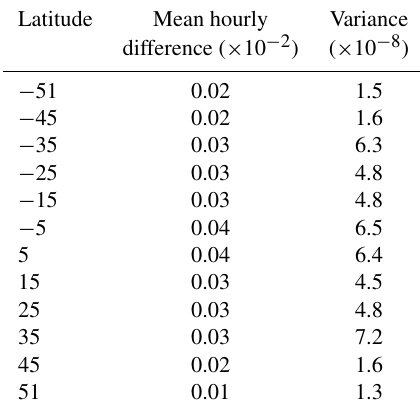
12.95 ◦ E based on three oscillations. The question,